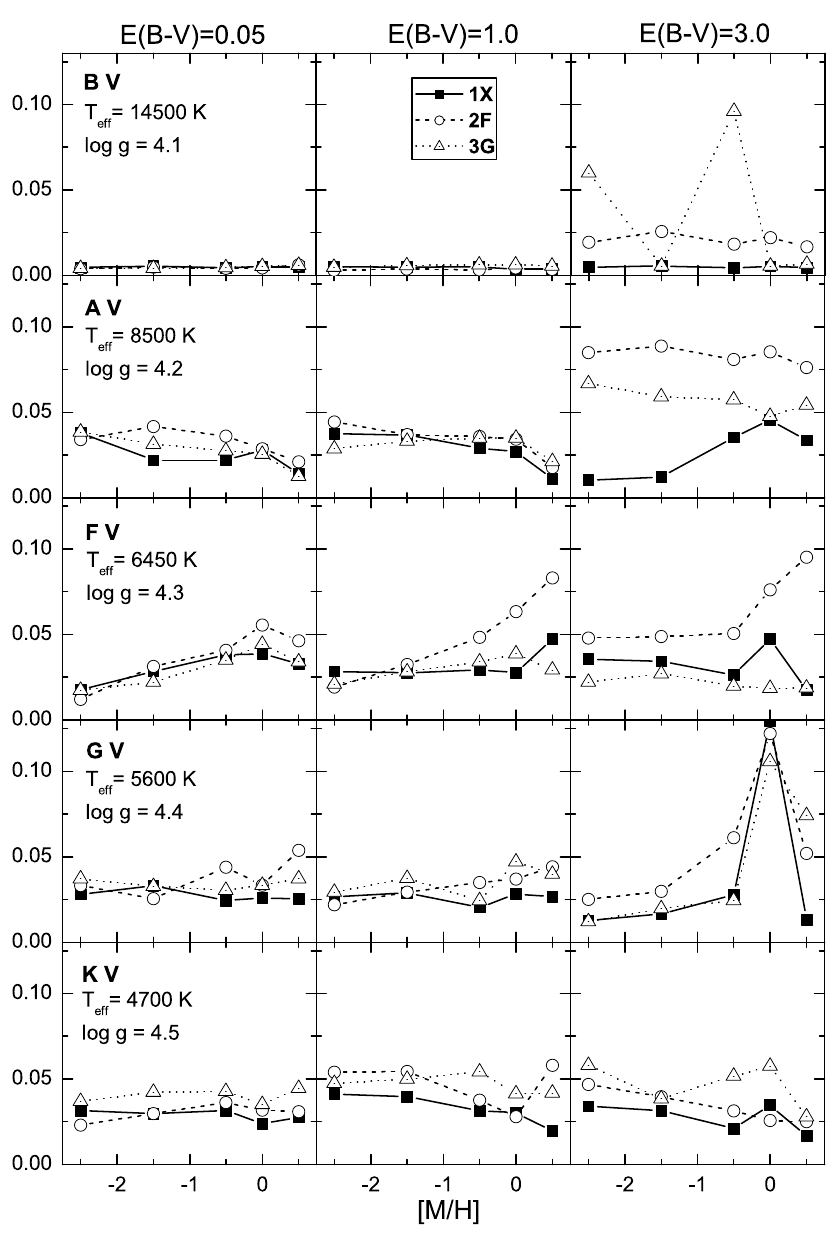
Fig. 1. Accuracy (r.m.s.) of E B − V determination vs. metallicity for the main sequence stars at three different color excesses. Photometric systems are marked by: 1X – filled squares; 2F – open circles; 3G –